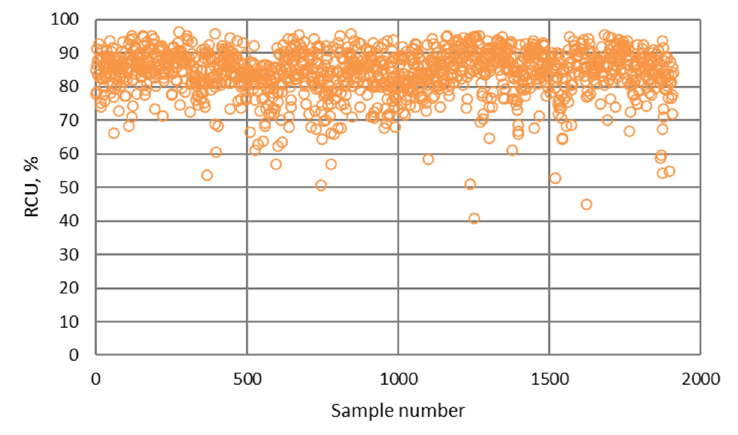
Figure A32. NN2 model—training dataset.